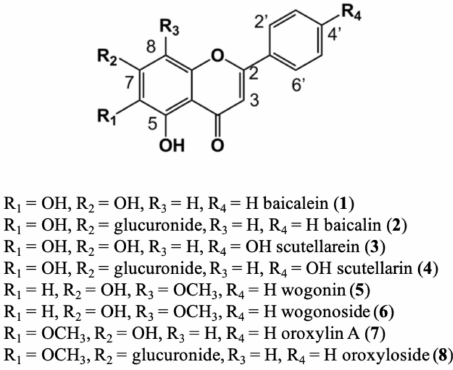
Figure 1. Chemical structures of the flavonoids of Scutellaria baicalensis employed in the